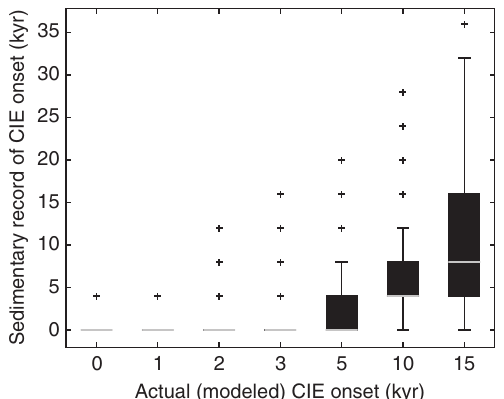
Fig. 6 Sedimentary record can exhibit a step change from pre-event to peak CIE values in mixed layer individuals for CIE onset durations of 3 kyr or less. At a sampling intensity of 5-individuals per sample and a sample every 2-cm (sedimentation rates of 0.5 cm/kyr), box and whisker plots indicate the likelihood of the sedimentary record preserving an apparent ‘ instantaneous ’ onset, (i.e., lacking intermediate-value individuals). We assume that abundance of mixed layer species declines linearly from pre- to post-event levels over the entirety of the CIE onset (Supplementary Fig. 13) with no gaps in the deposition of mixed-layer taxa. For each box plot , the lower and upper edges correspond to the twenty- fi fth and seventy- fi fth percentile, respectively, with the median ( fi ftieth percentile) indicated as a gray line . Box plot whiskers span ± 2.7 s.d, with data lying beyond the whiskers shown as black